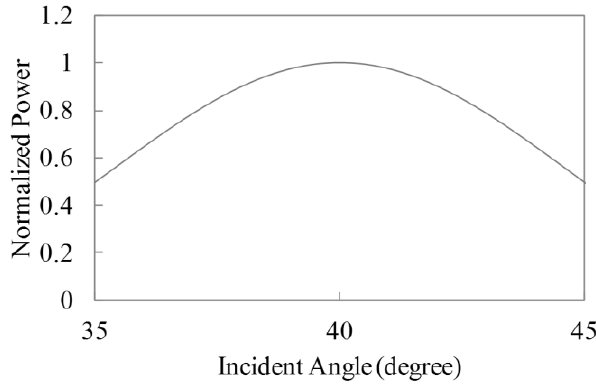
Figure 17. Antenna beam pattern in range direction.